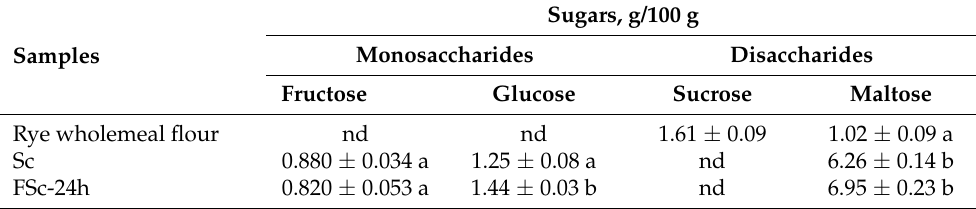
Sc—scalded rye wholemeal flour; FSc—scalded-fermented rye flour; 24h—after 24 h of fermentation; nd—not determined. Data expressed as mean values (n = 3) ± standard error (SE). a,b Mean values within a row with different letters are statistically significantly different ( p ≤